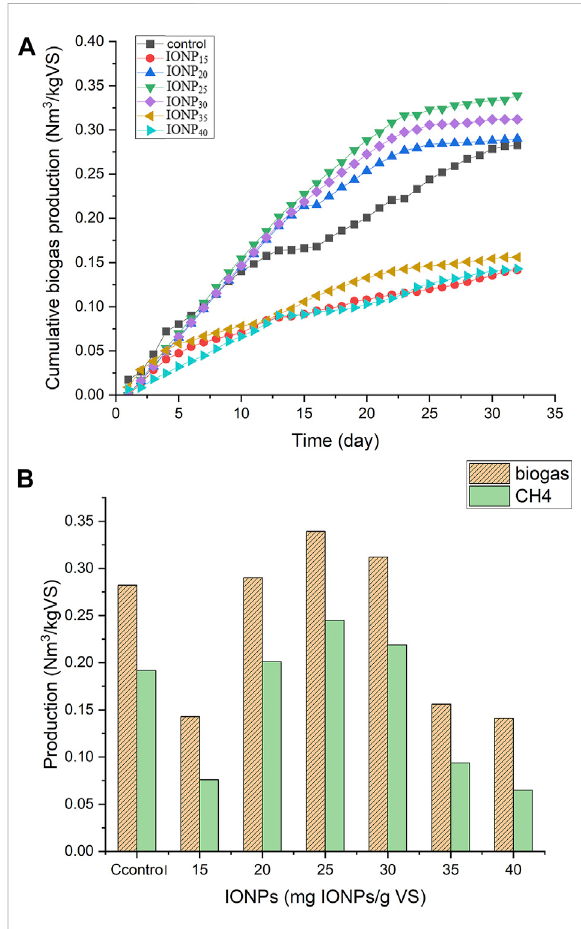
FIGURE 7 (A) -accumulative biogas production of different IONPs doses, (B) -biogas and methane yield for all IONPs